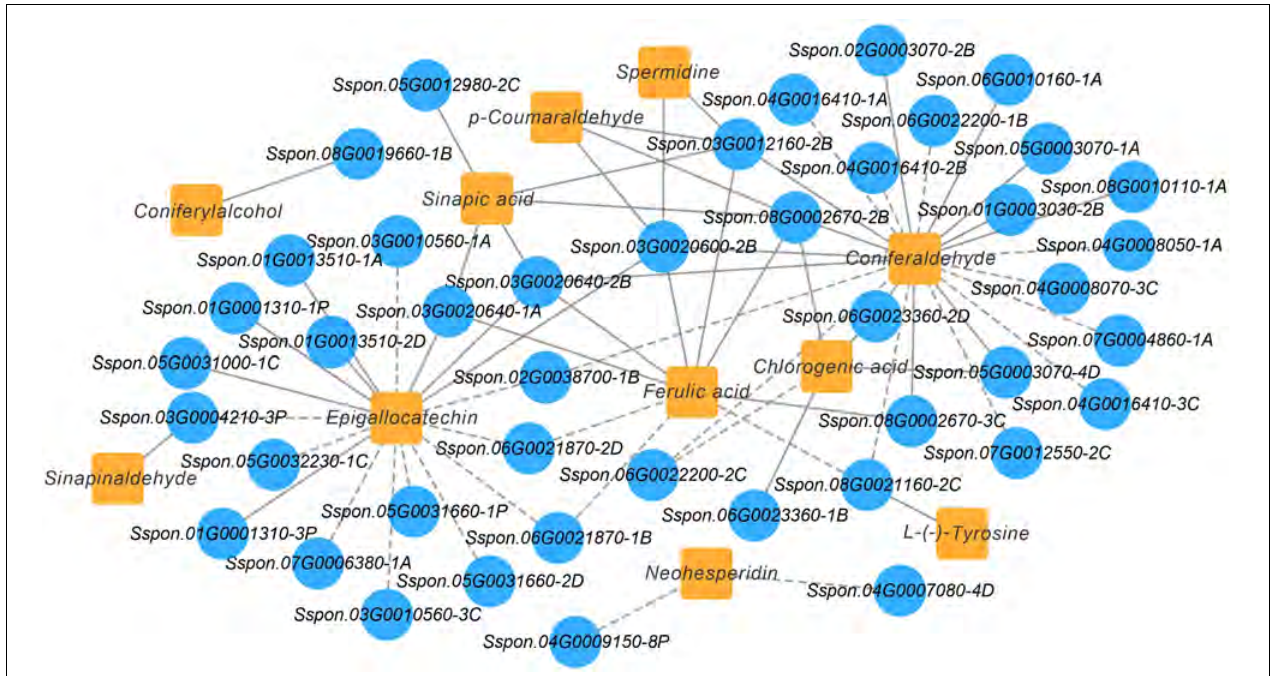
FIGURE 9 | Co-expression analysis illustrating genes and metabolites in phenylpropanoid and flavonoid biosynthesis pathway. Nodes represent genes or metabolites, and edges represent relationships between any two genes. Edges with solid and dashed lines represent positive and negative correlations, respectively, as determined by a Pearson correlation coefficient > 0.8 or < –0.8,